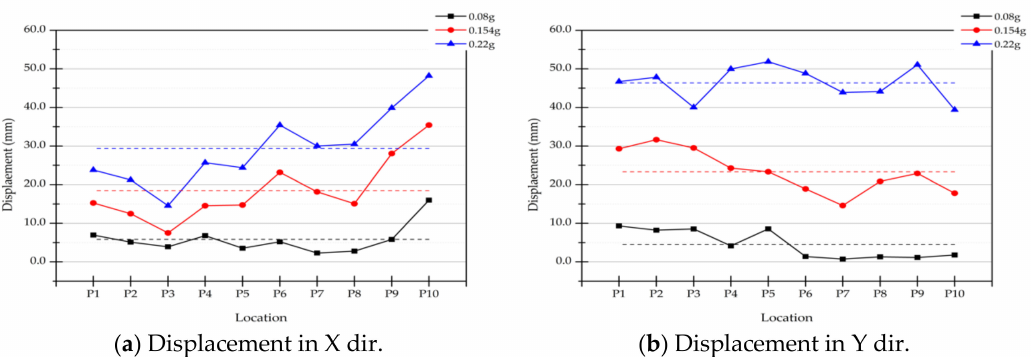
Figure 14. R-FBI displacement results using a nonlinear time history analysis method regarding performance levels. ( a , b ) Displacement at corresponding piers’